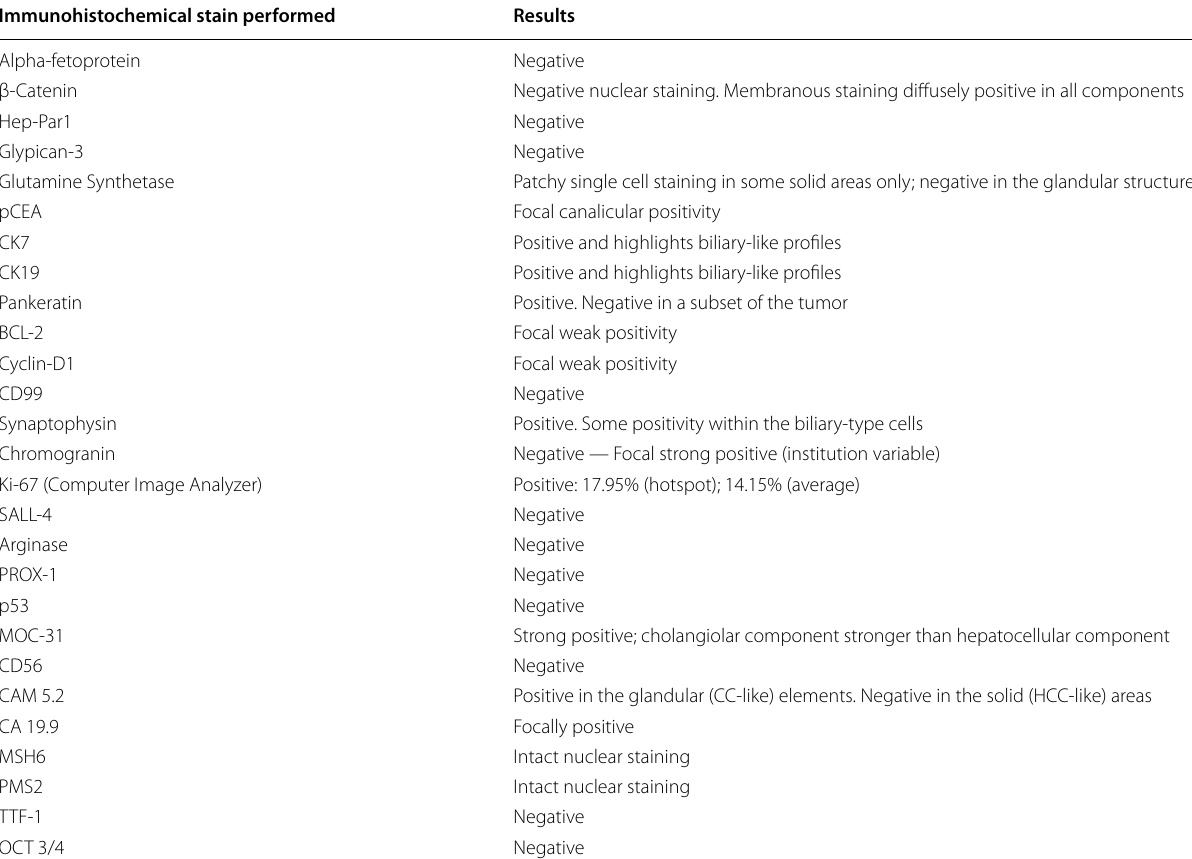
Stains were performed across three different institutions and are listed in the order in which they were ordered. Results were consistent across institutions unless otherwise specified Staining results refer to the tumor cells unless otherwise specified